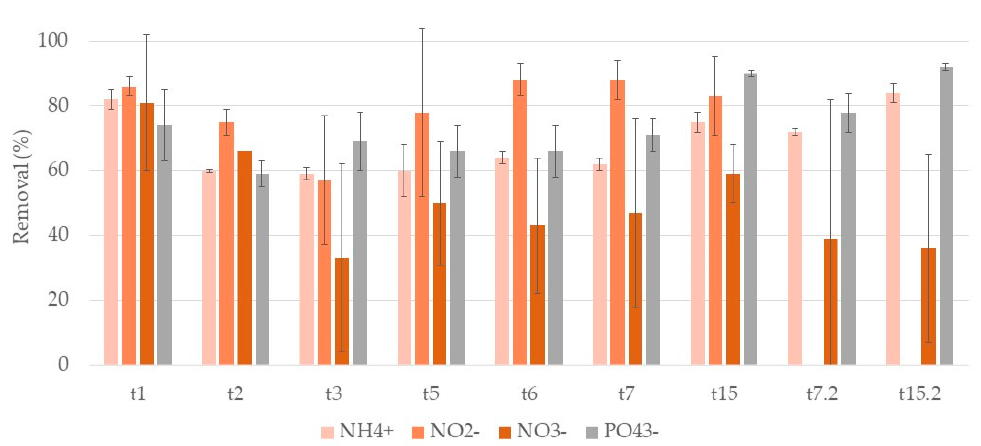
Figure 8. Removal percentage and respective standard deviation ( n = 3) for each nutrient, in CWs with lava rock (L) and P. australis during the two cycles of treatment. First cycle: samples taken after one day (t1), two days (t2), three days (t3), five days (t5), six days (t6), seven days (t7), and at the end of the two-week cycle (t15). Second cycle: samples taken after one week (t7.2) and at the end of the two-week cycle (t15.2) of treatment. At t2, only one replicate was considered for nitrate ion.